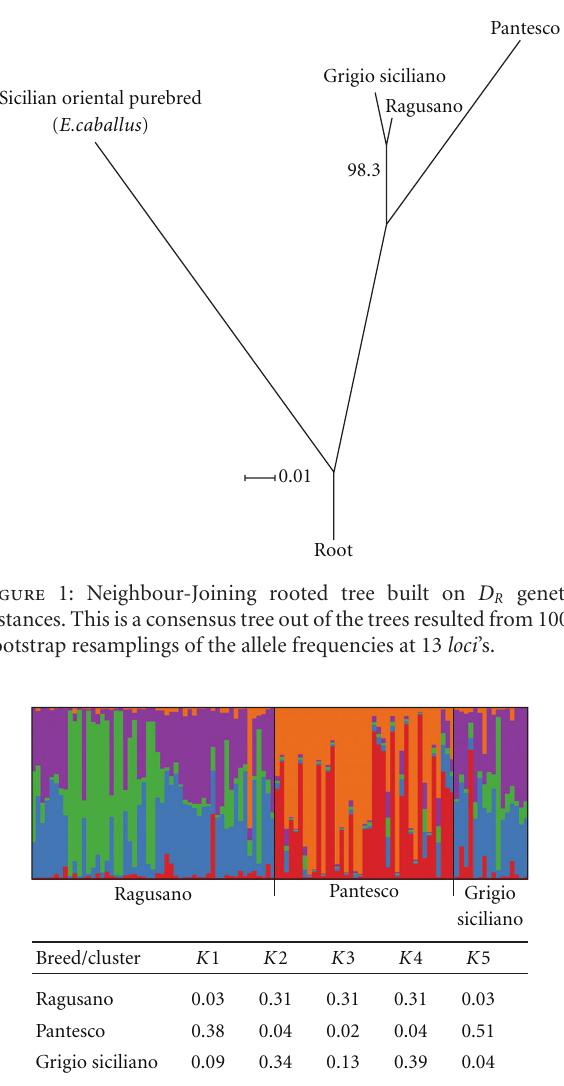
Figure 2: Breeds’ genome distribution into the K = 5 inferred clusters. Analysis, conducted on the allele frequencies of 13 loci